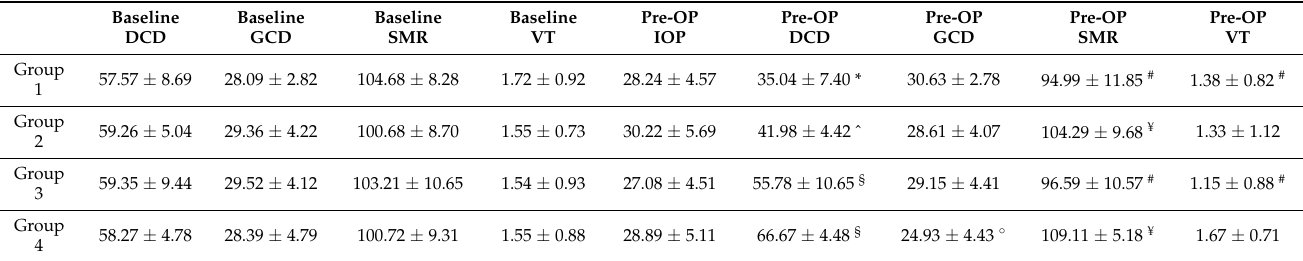
Table 2. Confocal microscopy parameters.